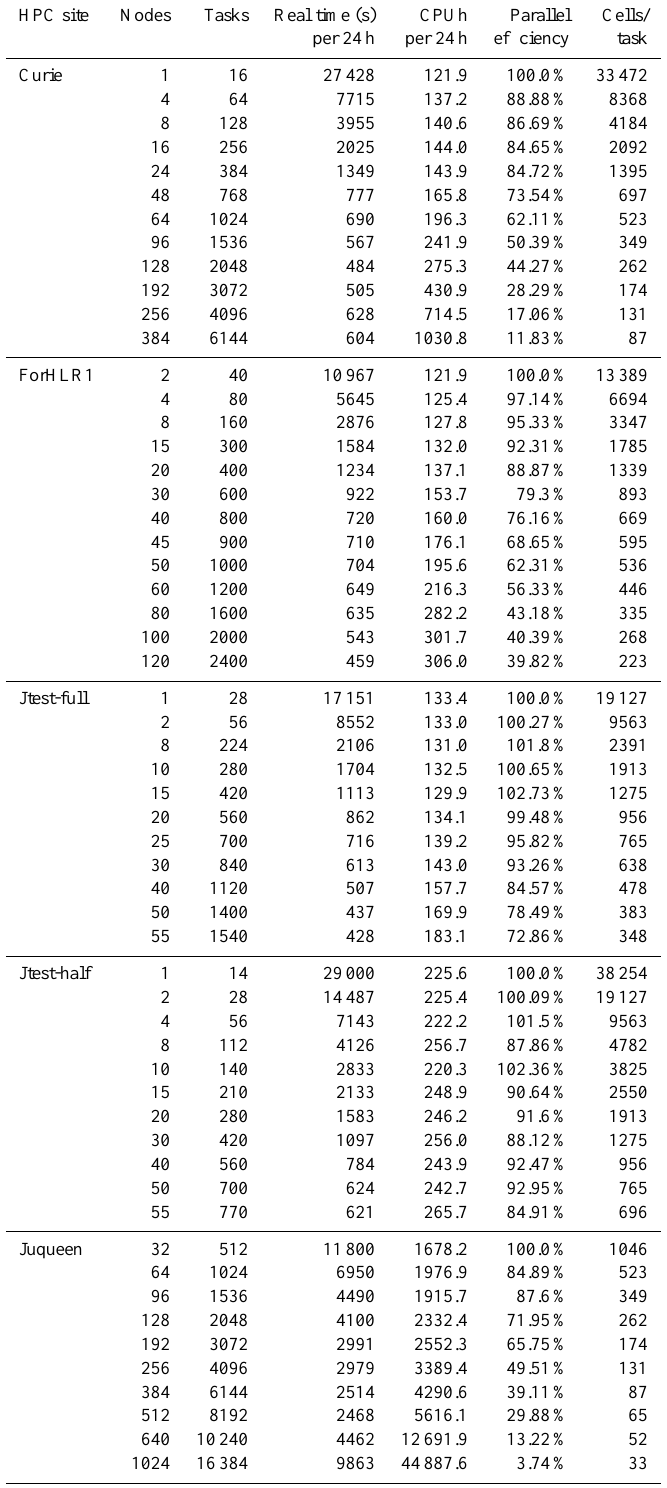
Table F1. Scaling tests for the 60–12km variable mesh on the four HPC